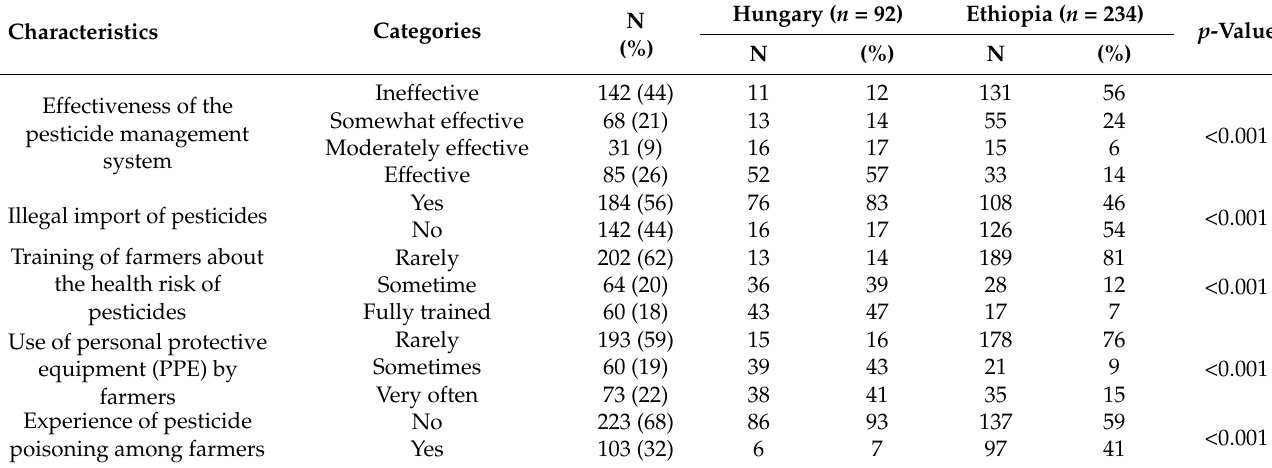
Table 5. Experienced practice of pesticide use and preventive measures among officers in Hungary and Ethiopia. Characteristics